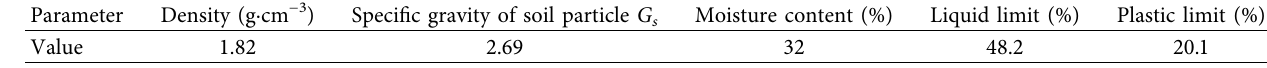
Table 1: Physical and mechanical properties of undisturbed soil.